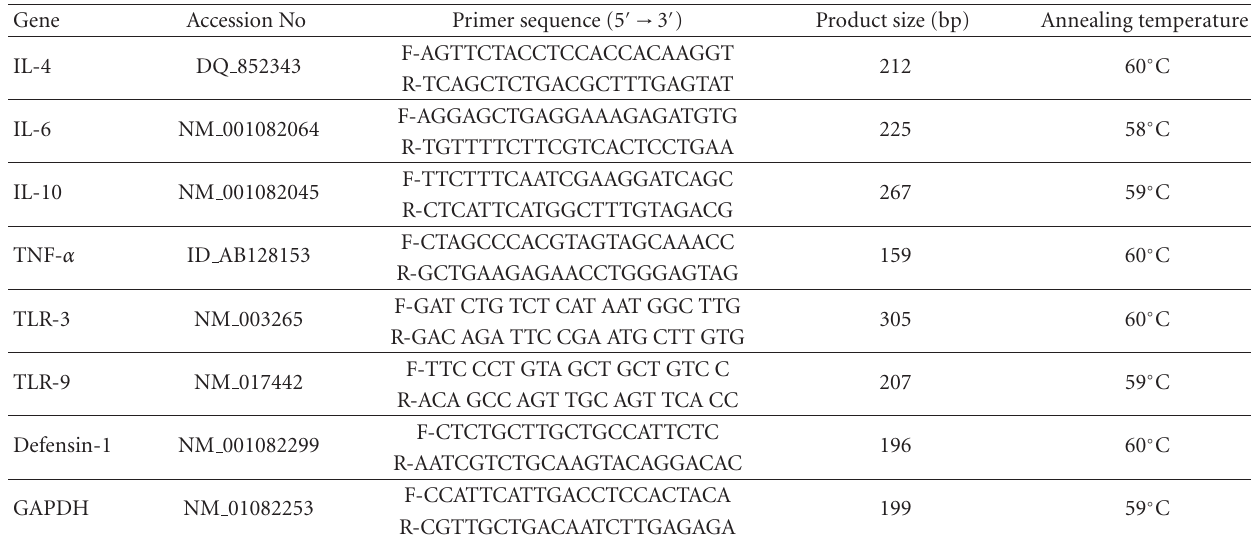
Table 1: Oligonucleotide primers used for the